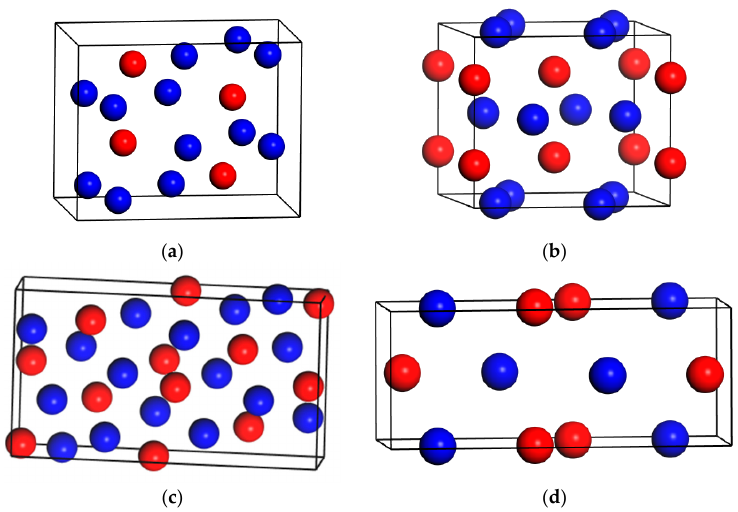
Figure 1. The crystal structure of Ni x B y compounds (red balls represent B atoms, blue balls represent Ni atoms) ( a ) Ni 3 B; ( b ) Ni 2 B; ( c ) Ni 4 B 3 ; ( d ) NiB.